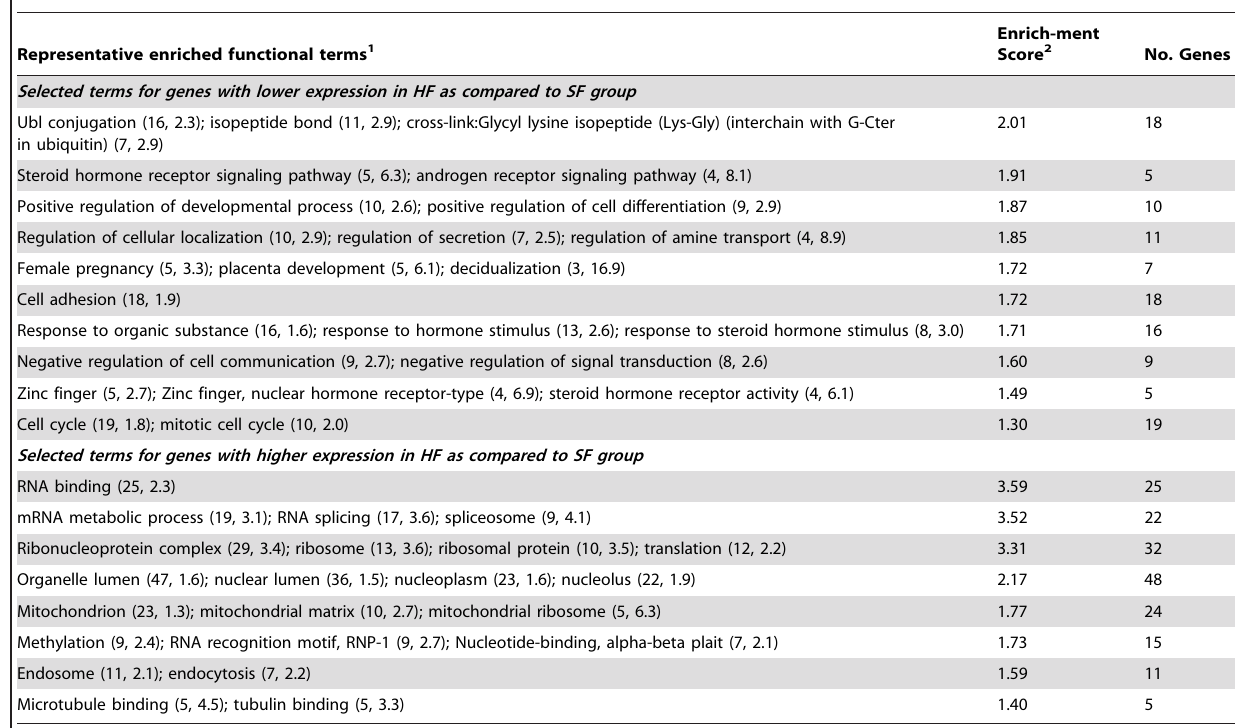
Table 4. Selected overrepresented functional categories for genes with differential expression in High Fertile as compared to Subfertile heifers (nominal P-value , 0.01).